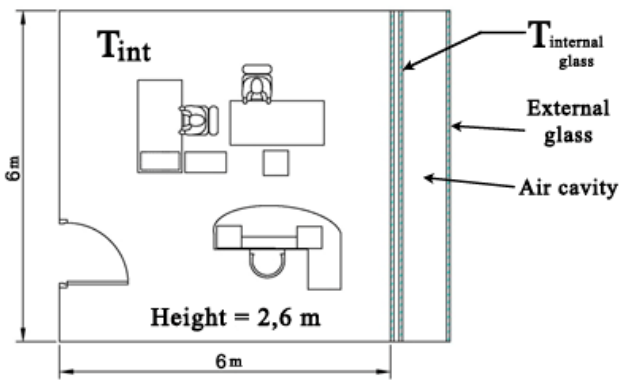
Figure 14. Dimensions and characteristics of the considered office.